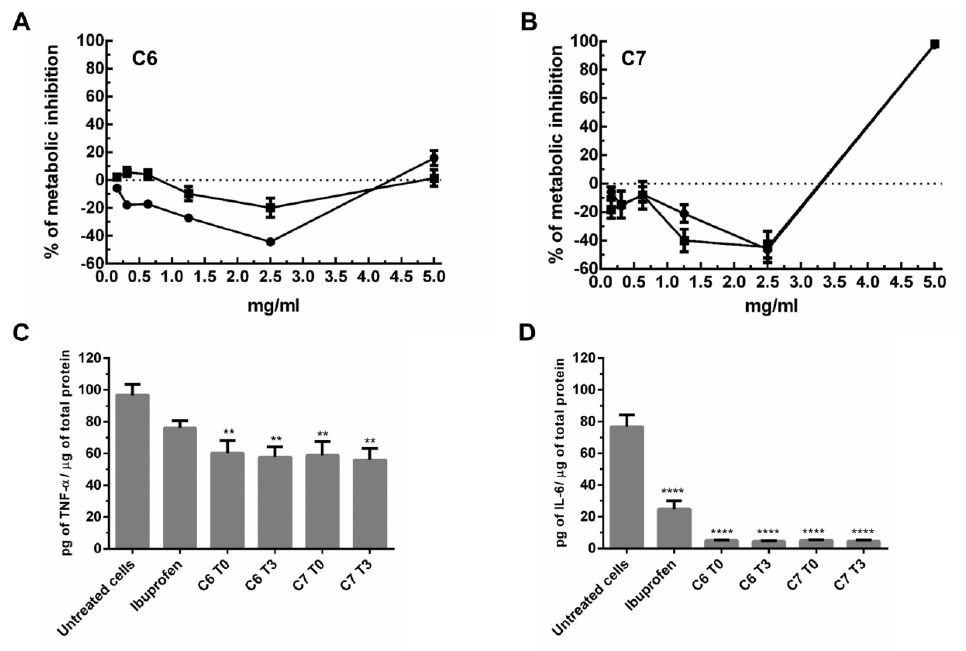
Figure 2. Effect of the distilled samples on macrophages. ( A , B ) Cytotoxicity evaluation of C6 and C7 by measuring the metabolic inhibition (PrestoBlue assay). Dots correspond to T0 samples and squares correspond to T3 samples ( C , D ) evaluation of TNF- α and IL-6 levels, respectively, in macrophages under an inflammatory stimulus (LPS). Values are expressed as pg of cytokine normalized to the total protein content. Ibuprofen at 1 mM was used as an anti-inflammatory control. One-way ANOVA was used for statistical analysis. ** p ≤ 0.01; **** p ≤ 0.0001. Pharmaceuticals 2021 , 14 , x FOR PEER REVIEW